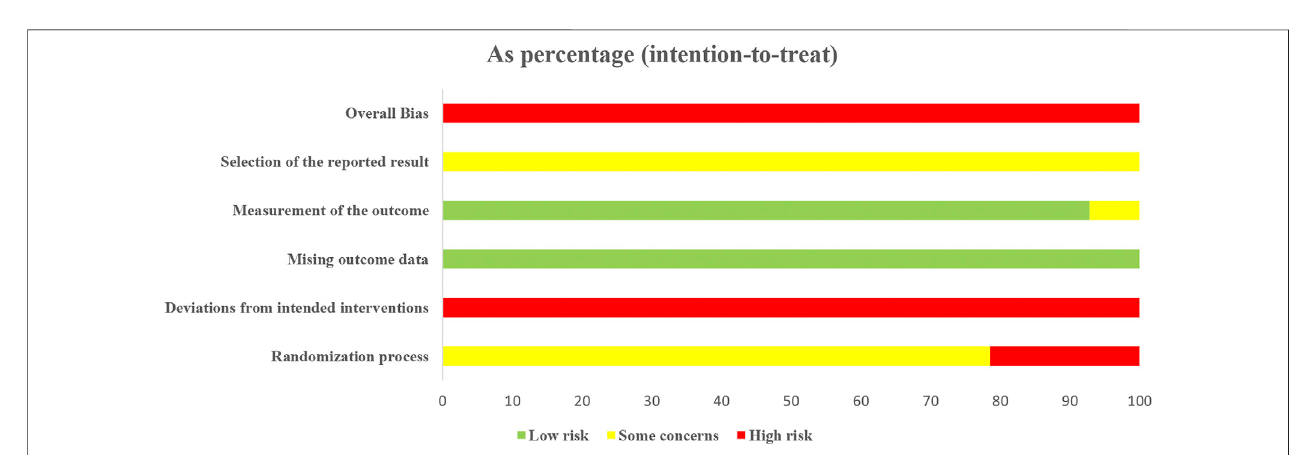
FIGURE 3 | Risk-of-bias